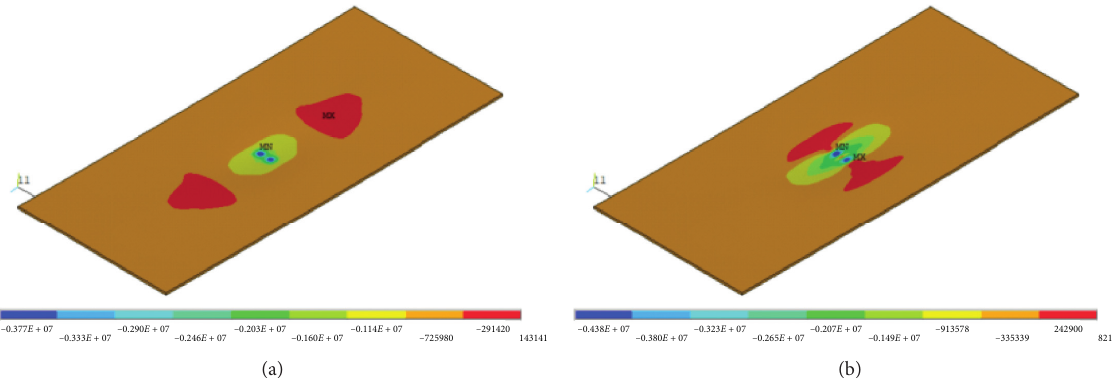
Figure 16: The stress distribution diagram of the midspan pavement under wheel load under full-bridge action. (a) The longitudinal stress diagram. (b) The transverse stress